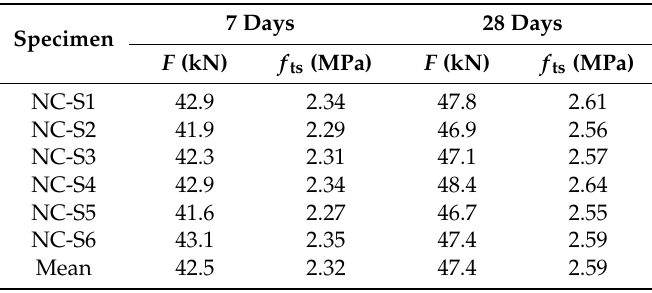
Table 3. Splitting test results of test specimen series NC-S (normal concrete with shaking table